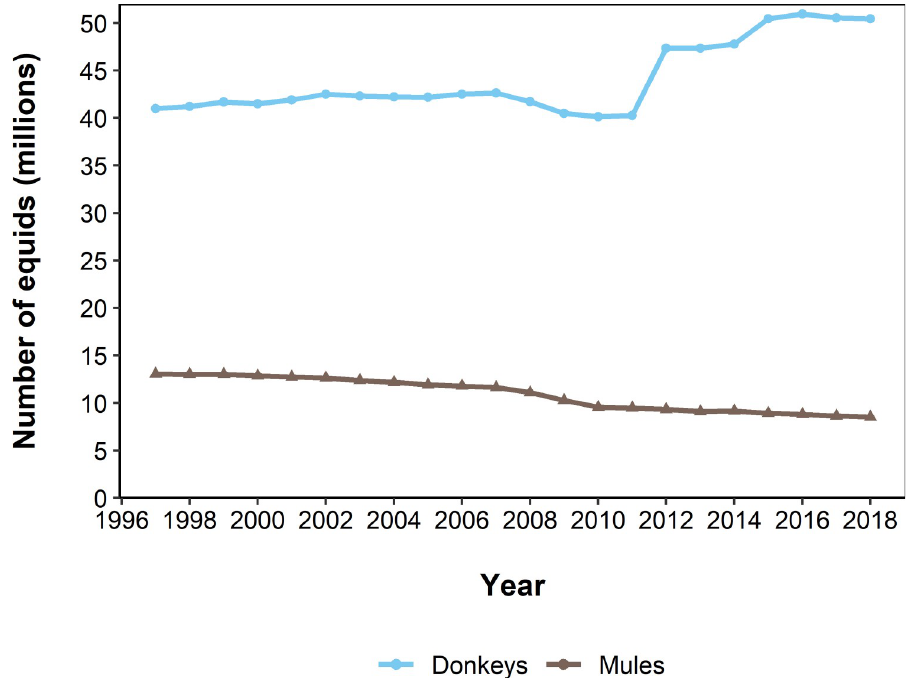
Fig 1. Global population trend of donkeys and mules. Data from FAOSTAT. The blue line and circles represent donkey population trends, the brown line and triangles represent mule population trends.